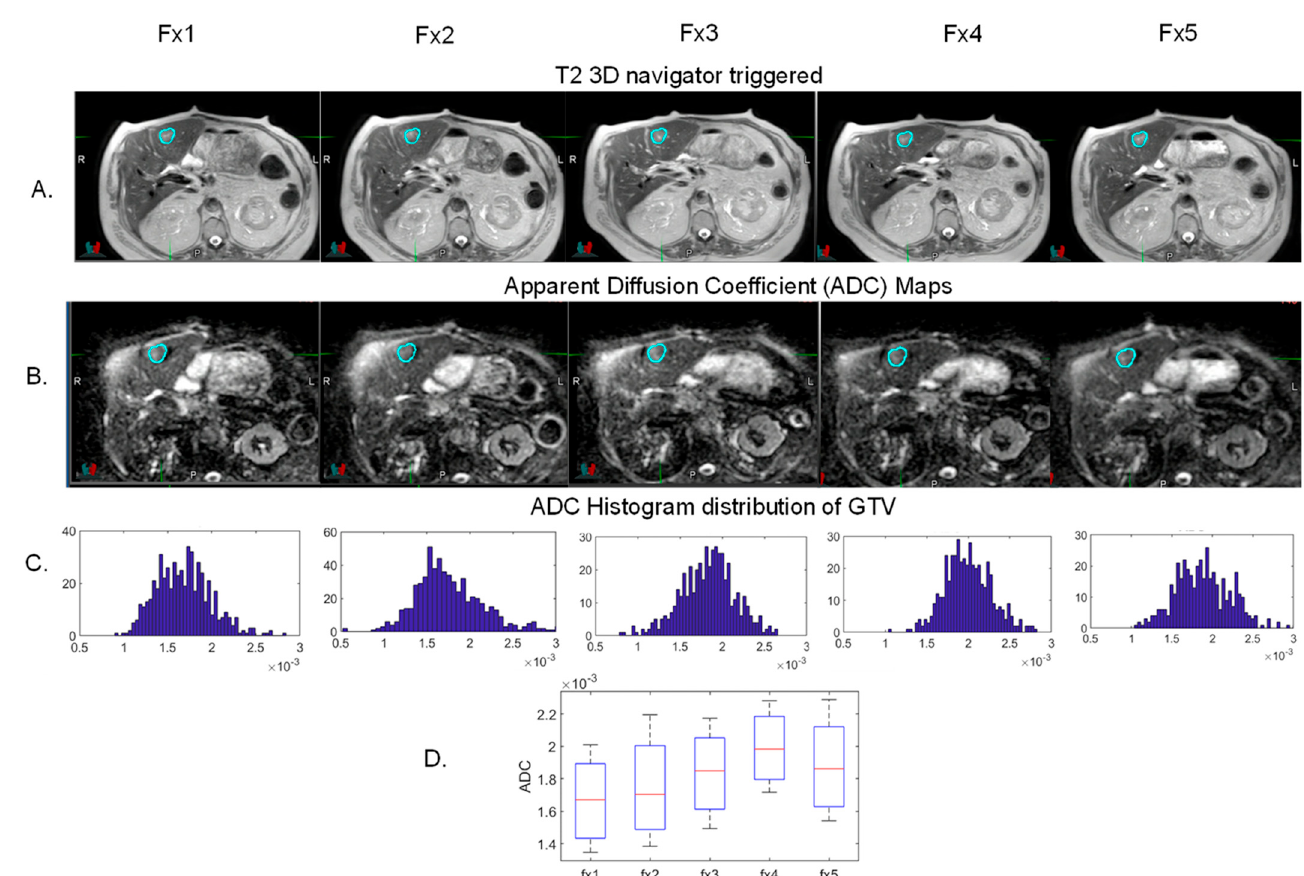
Figure 2. Treatment response of an example liver lesion using T2w MRI and diffusion weighted MRI derived apparent diffusion coefficient maps. ( A ) T2w 3D navigator triggered MRI for during treatment fractions with GTV lesion displayed. ( B ) Apparent diffusion coefficient maps derived using four b-values (0, 30, 150 and 550 mm 2 /s). ( C ) Histogram distribution of ADC values within the GTV. ( D ) Trend analysis of ADC values using boxplot.